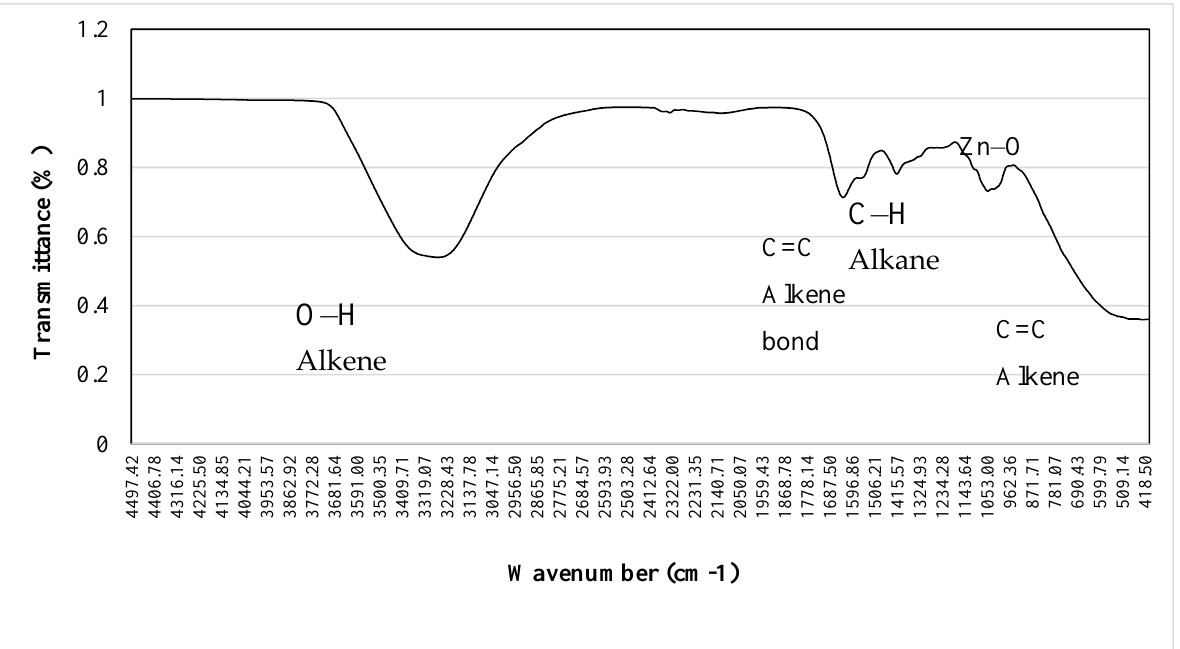
Figure 1. UV-vis absorption spectrum ( A ), size distribution ( B , E ), and zeta potential ( C , D ) of C. siliqua bio-ZnONPs.